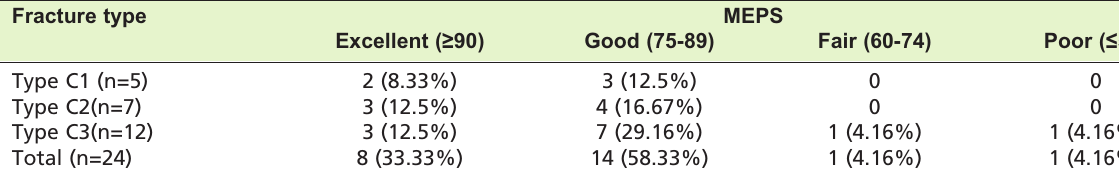
Quality analysis of Mayo Elbow Performance Score Table II: